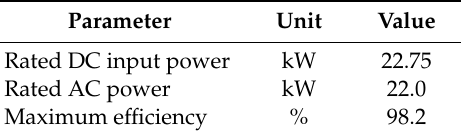
Table 3. Inverter characteristics for RS and